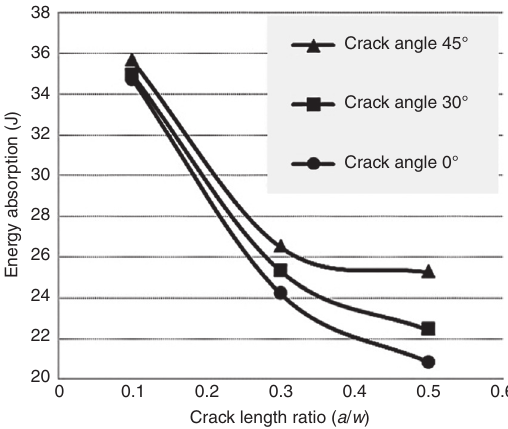
Figure 6 Energy absorption of the unrepaired cracked specimens.